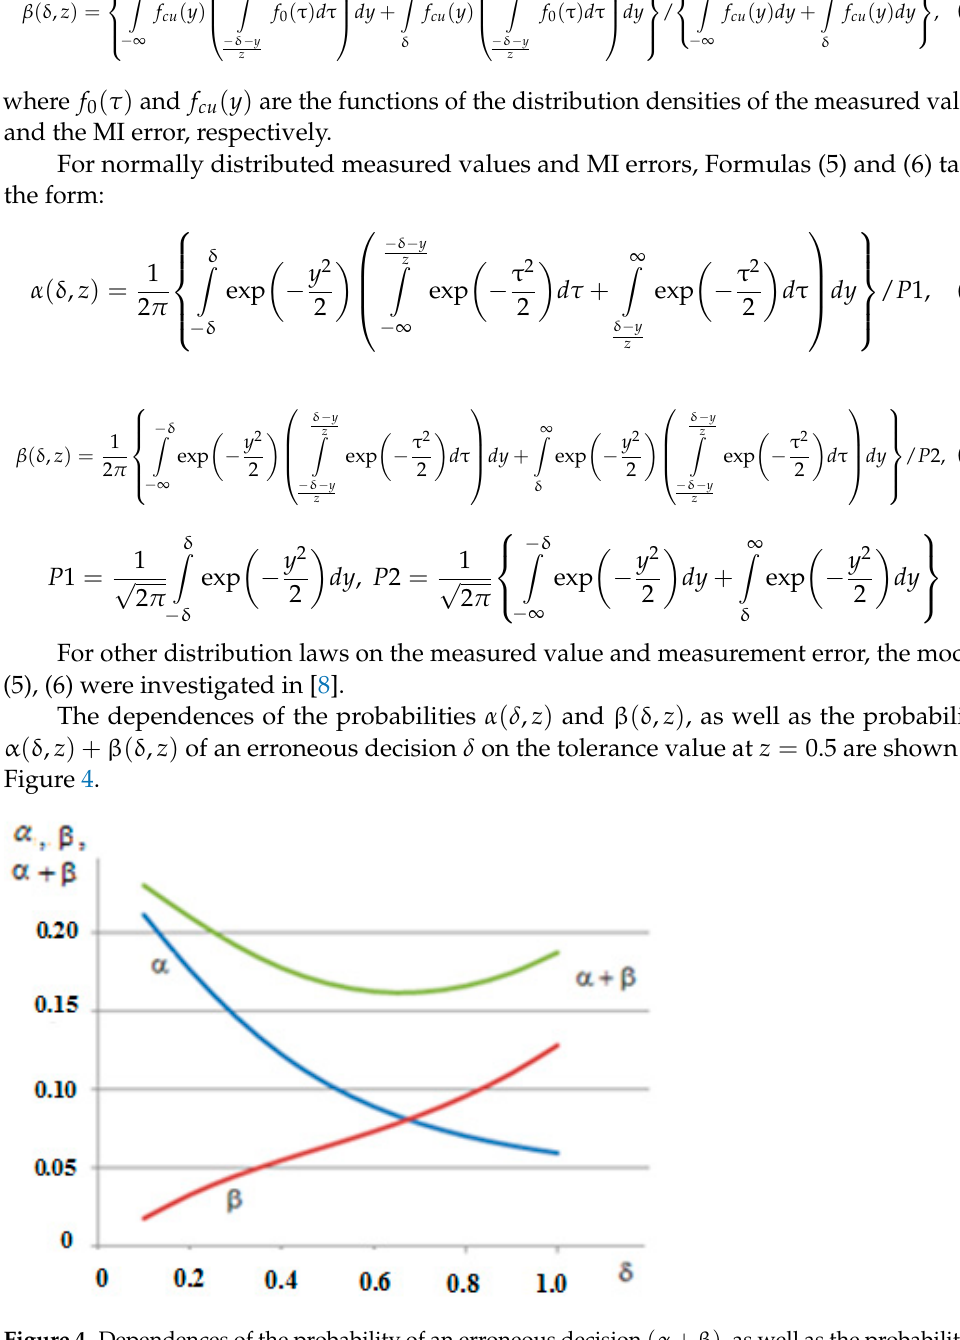
β+α , as well as the proba- = z .